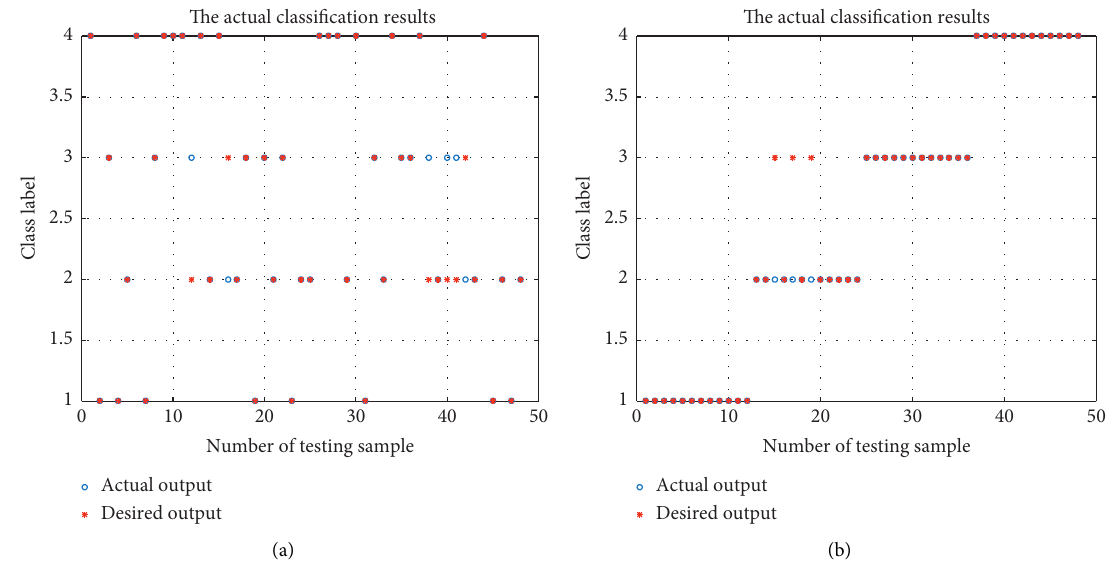
Figure 14: Recognition result of the experimental signal based on power spectrum entropy. (a) SVM model. (b) PSO-SVM